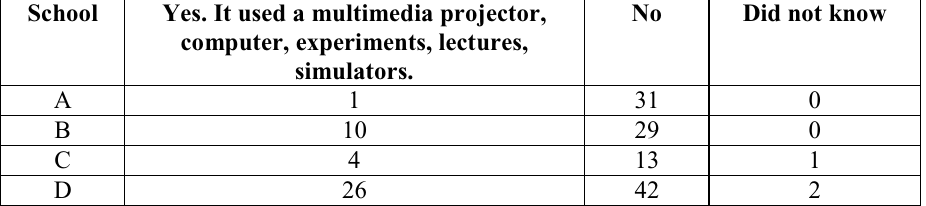
Table 1: Use of technological resources to aid the teaching of Physics in schools. School